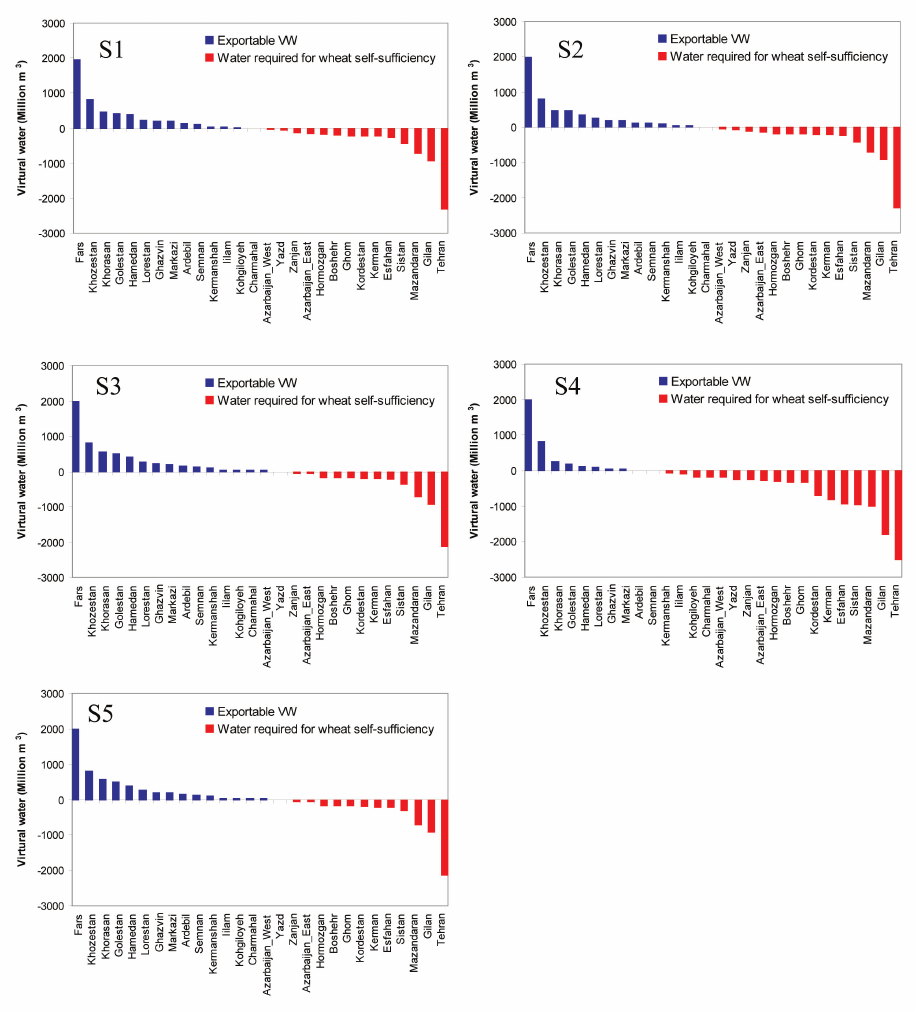
Fig. 7. Long-term (1990–2004) average virtual water exported through wheat trade in provinces where excess wheat is produced (blue) and the amount of water required to produce wheat in the importing provinces